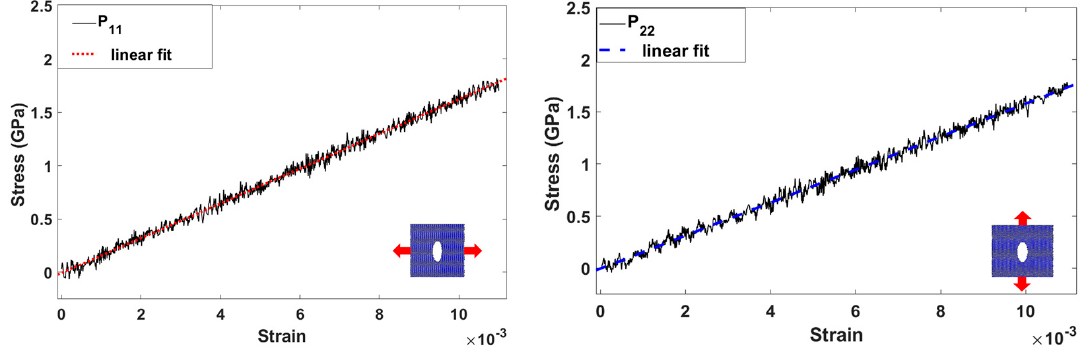
Figure 3. Examples of stress-strain relationship during uniaxial tension in two directions.